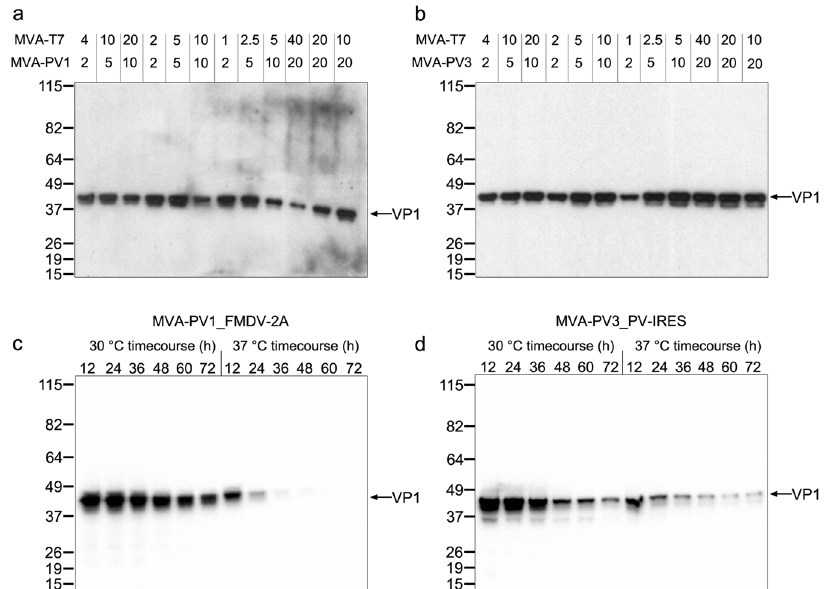
Fig. 2 Small-scale expression of MVA-PV1 and MVA-PV3 constructs to determine optimum parameters for large-scale infection/ expression. a , b Western blots of 6-well screens for MVA-PV1_FMDV-2A ( a ) and MVA-PV3_PV-IRES ( b ) co-infected with MVA-T7 to test optimum MOI ratios for expression. MOI ratios tested in each lane are shown above the blot for MVA-T7 and either MVA-PV1_FMDV-2A (MVA-PV1, a ) or MVA-PV3_PV-IRES (MVA-PV3, b ). c , d Western blots of MVA-PV1_FMDV-2A ( c ) and MVA-PV3_PV-IRES ( d ) co-infected with MVA-T7 at their optimum MOIs determined from ( a ) and ( b ) to test temperature (30 °C and 37 °C) and time point of harvest (12 – 72 h, in 12 h time points). Detection was with anti-poliovirus blend of monoclonal antibodies MAB8566 (Millipore).